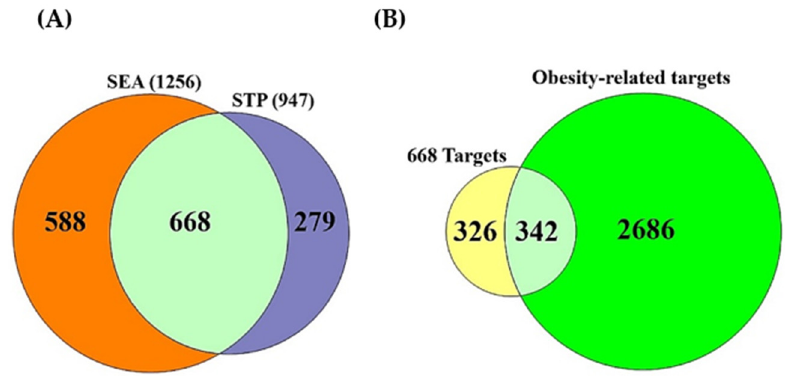
Figure 2. ( A ) The common 668 targets between SEA (1256) and STP (947). (B ) The common 342 targets between the 668 targets and obesity-related targets (3028).